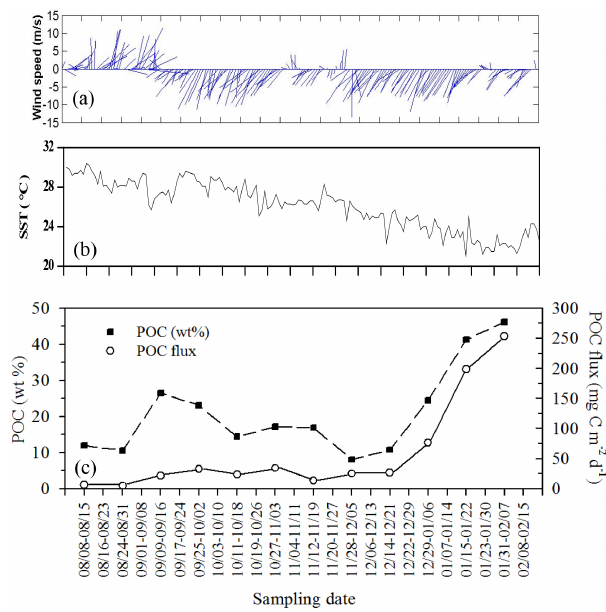
Figure 11. Temporal variability of wind speed (a) , surface temper- ature (b) , and their corresponding vertical fluxes and weight (%) of POC (c) during the period the trap was moored (from summer to winter: 8 August 2004–15 February 2005) at a depth of 120m on the site (18 ◦ 19.661 (cid:48) N, 115 ◦ 44.103 (cid:48) E) close to the SEATS station. All data were adapted from unpublished data in Tsai’s thesis (Tsai,